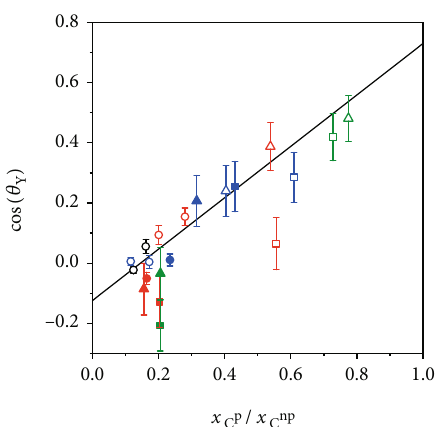
Þ as function of Y